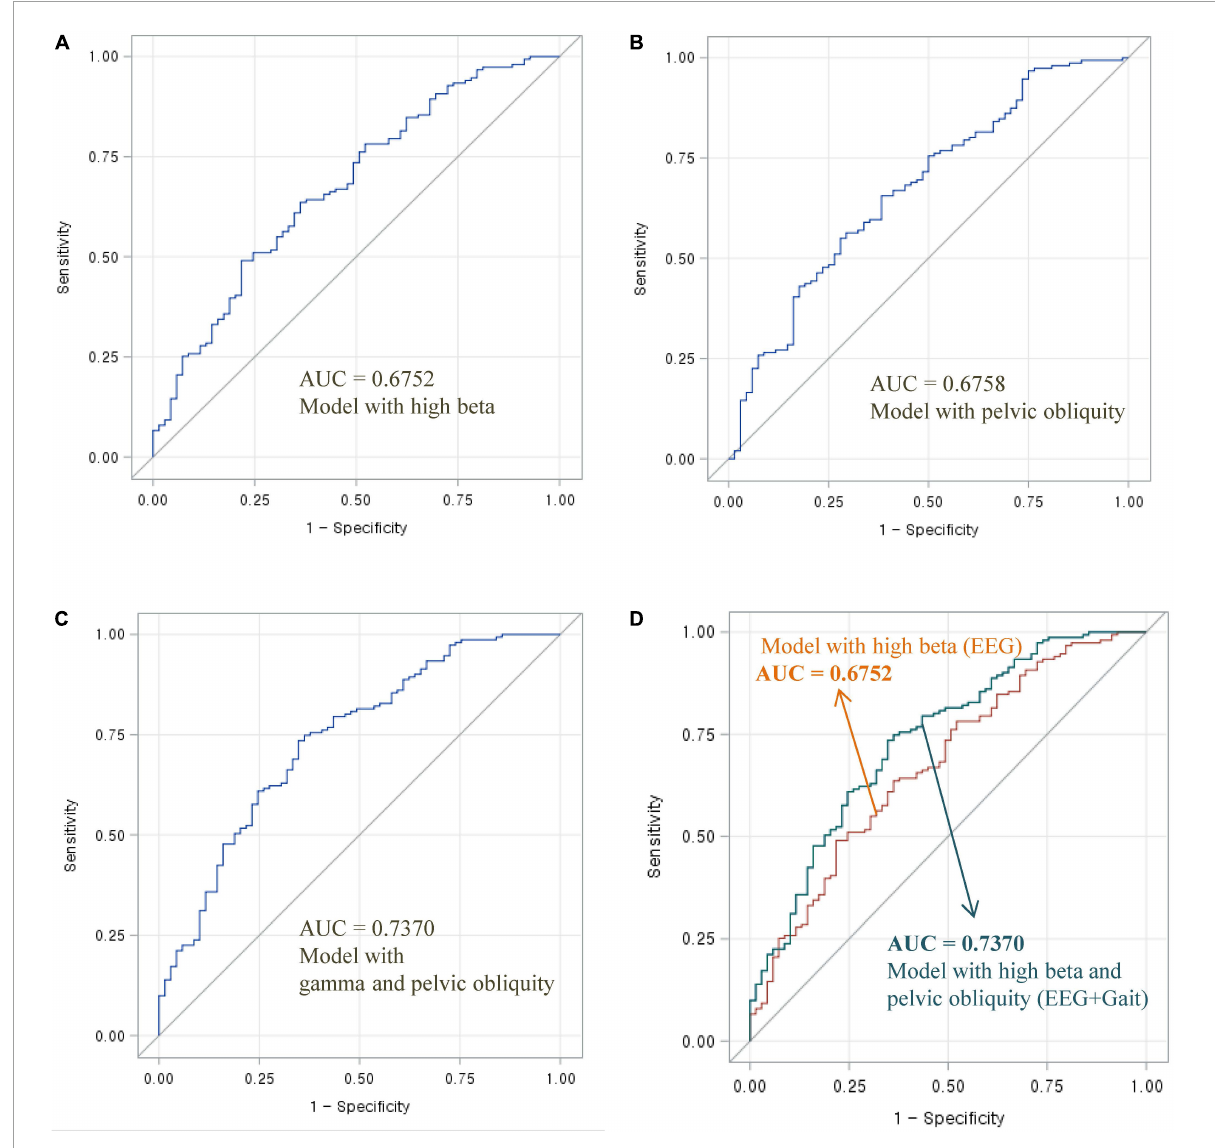
FIGURE1 Area under the ROC curve of EEG and gait parameters for classifying MCI and normal cognition: (A) Model with high beta power, (B) model with pelvic oblique, (C) combined model with high beta power and pelvic oblique, and (D) comparison of AUC